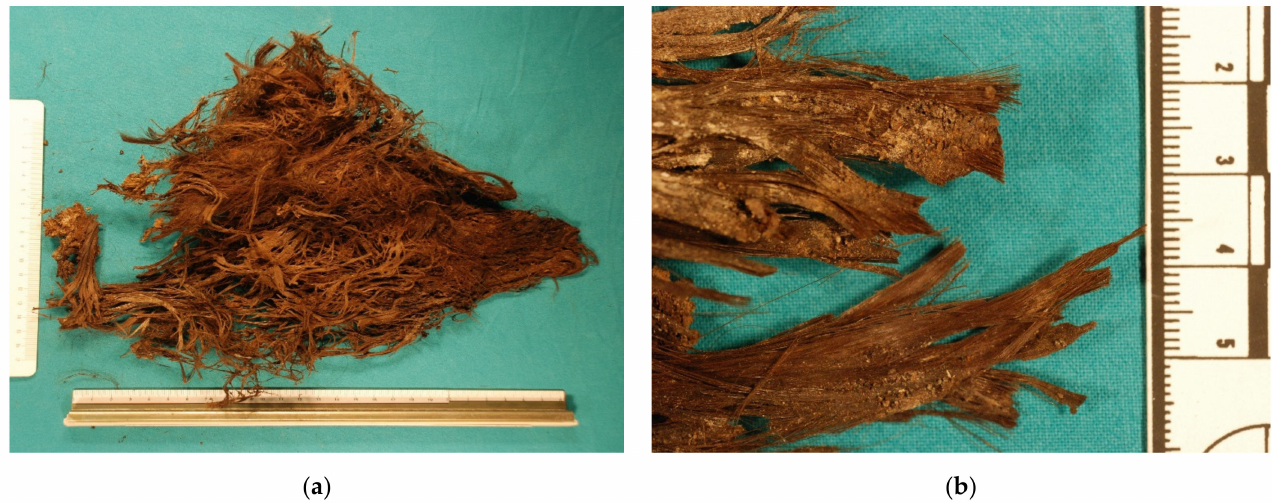
Figure 2. ( a ) Strands of hair found nearby the skeletal remains of a 16 year old female found in Italy 17 years after death; ( b ) close up of the lock of hair clearly cut by sharp force trauma